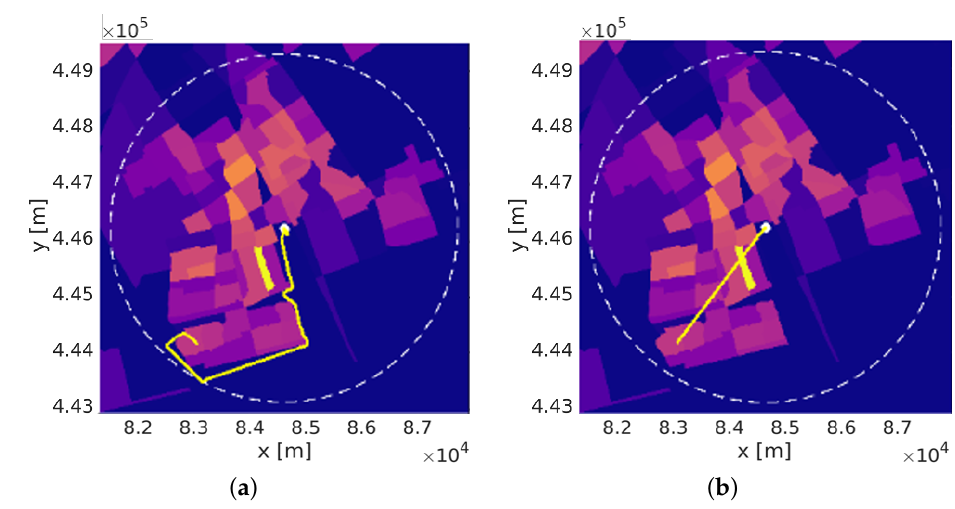
Figure 2. An example of generated paths by setting ( a ) ω ratio = 1:0: a path over low-populated areas; ( b ) ω ratio = 0:1: a short path.